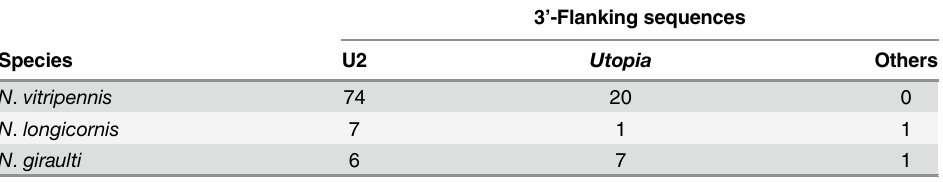
Table 4. 3 ’ Flanking sequences of Utopia elements in three Nasonia